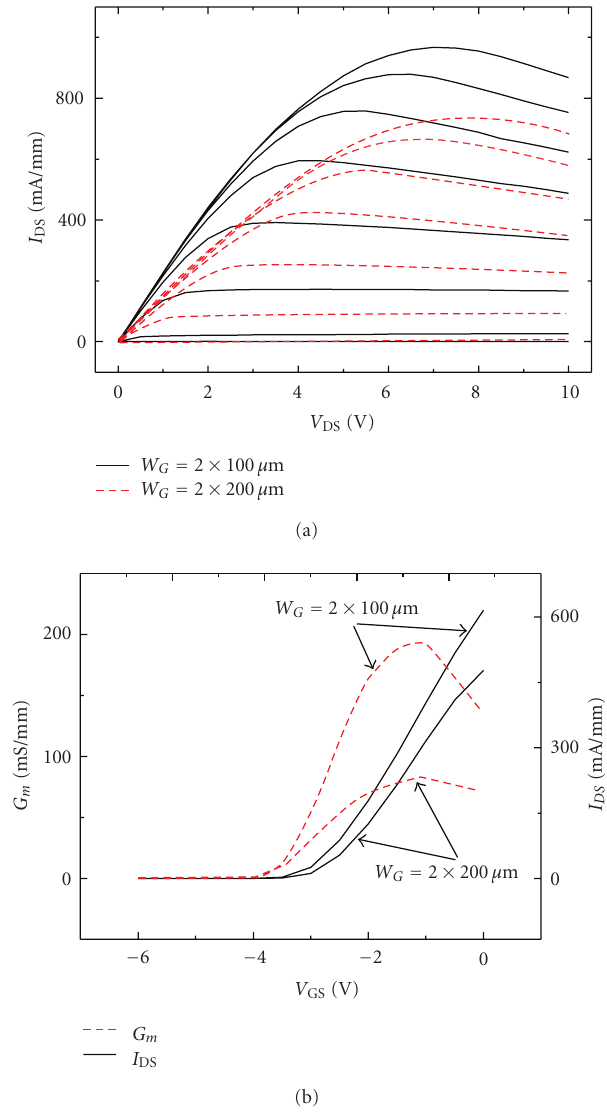
Figure 11: (a) I DS against V DS and (b) G m against V GS character- istics of fabricated two-finger 2.5 μ m gate length AlN/GaN MOS- HEMT devices with optimised 20 s of etching time with passivated mesa sidewalls. The devices are biased from V GS = +3V to − 4 V with step size of